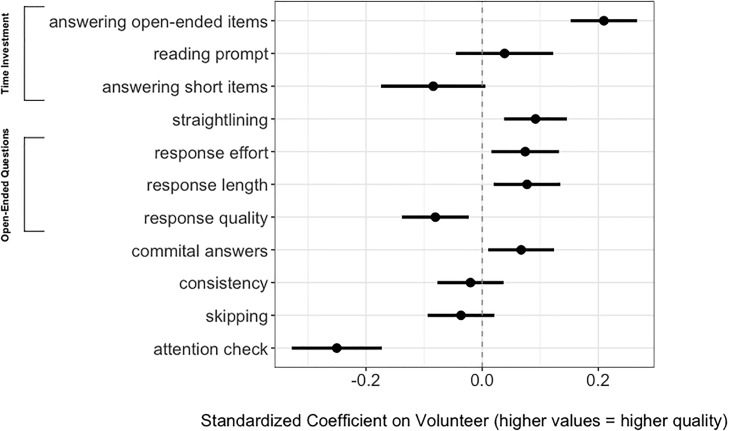
Standardized “Volunteer” coefficients for all response quality tests.Coefficients on “reading prompt”, “answering short items”, and “attention check” represent results for a single substantive survey, because they were not included in both questionnaires.